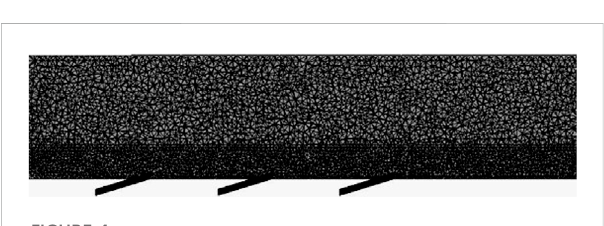
FIGURE 4 The grid division diagram of sand barrier model for ribbon gauze.